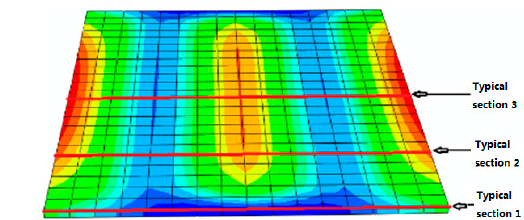
Figure 9. Typical sections of the cover.